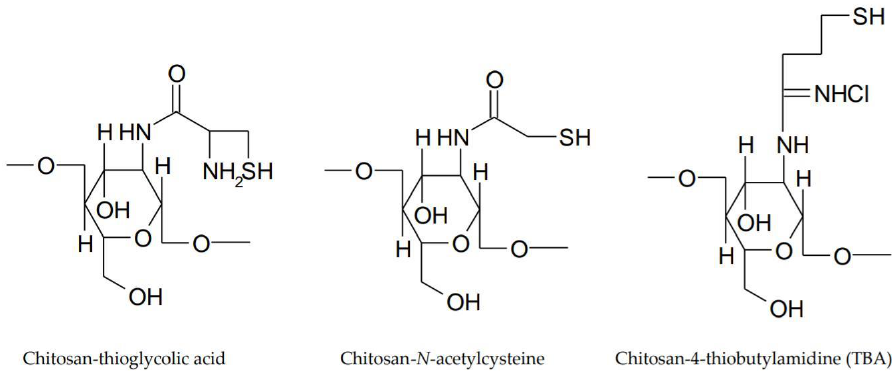
Figure 4. Thiolated derivatives of chitosan.